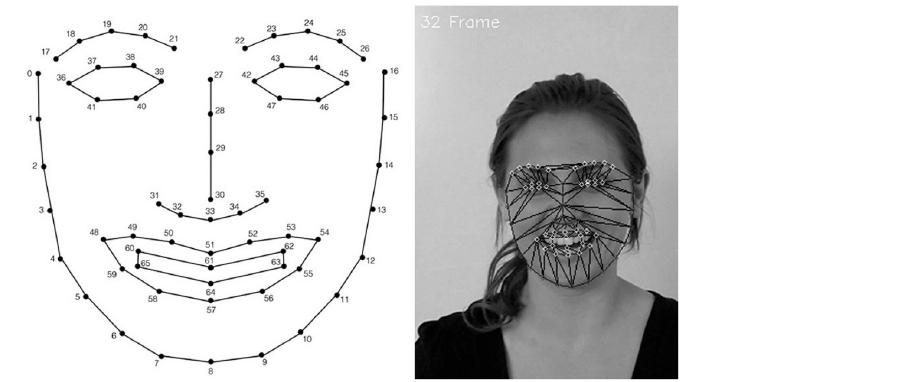
Fig 3. Visual tracking of facial landmarks.